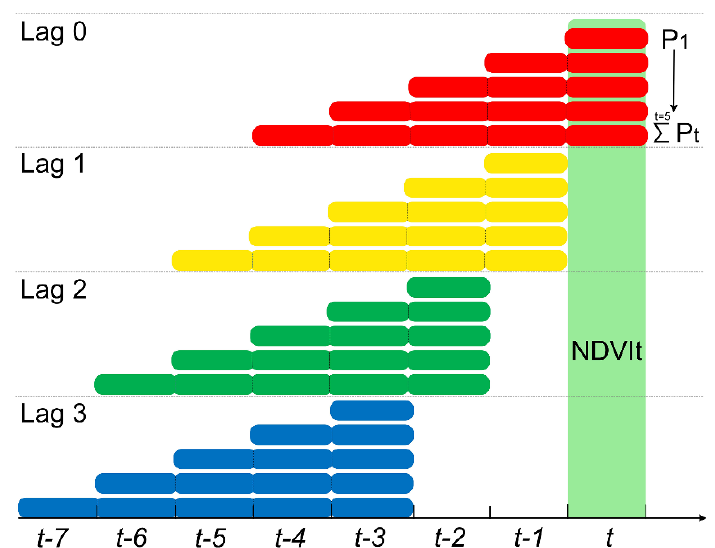
Figure 2. Schematic presentation of the lag effect of precipitation on NDVI. The horizontal bars represent the precipitation time series. The vertical bar represents the NDVI at time t . The impact of lag 0, 1, 2, and 3 on the NDVI is represented by the colors red, yellow, green, and blue, respectively. For example, lag 0 represented monthly NDVI values at time t were correlated with the precipitation from time t (concurrent month) to time t − 1 (previous one month), or t − 2 (previous two month), or t − 3 (previous three month), or t − 4 (previous four